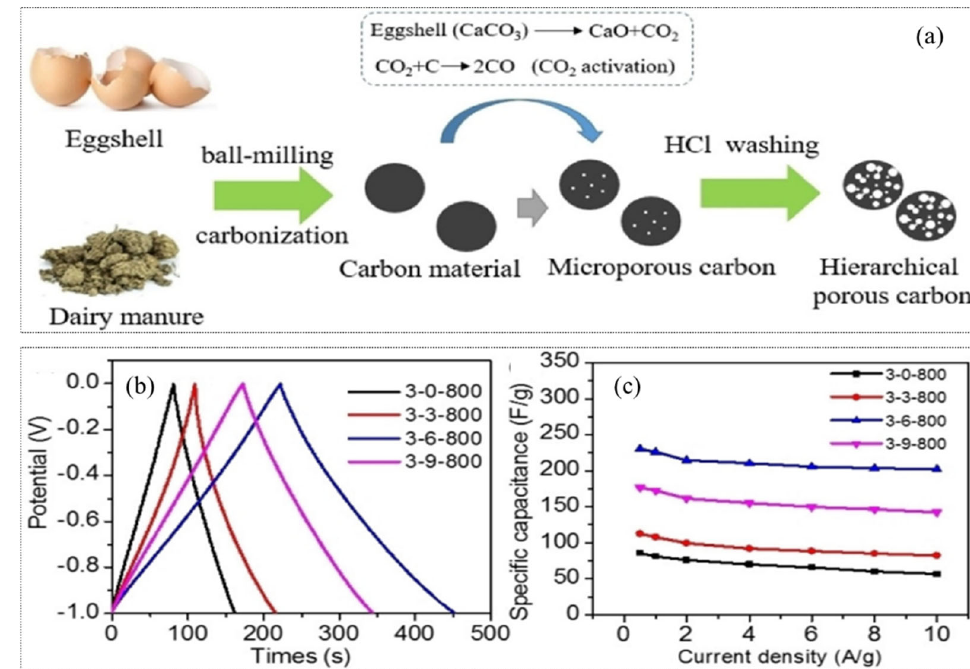
Figure 16. ( a ) Synthesis scheme of hierarchical porous carbon produced from dairy manure and eggshells via the BM technique ( b ) charge and discharge curves of samples at current density of 1 A/g ( c ) specific capacitance of samples at different current densities. Reprinted with the permis-sion from Ref. [238]. Copyright © 2018 John Wiley & Sons.